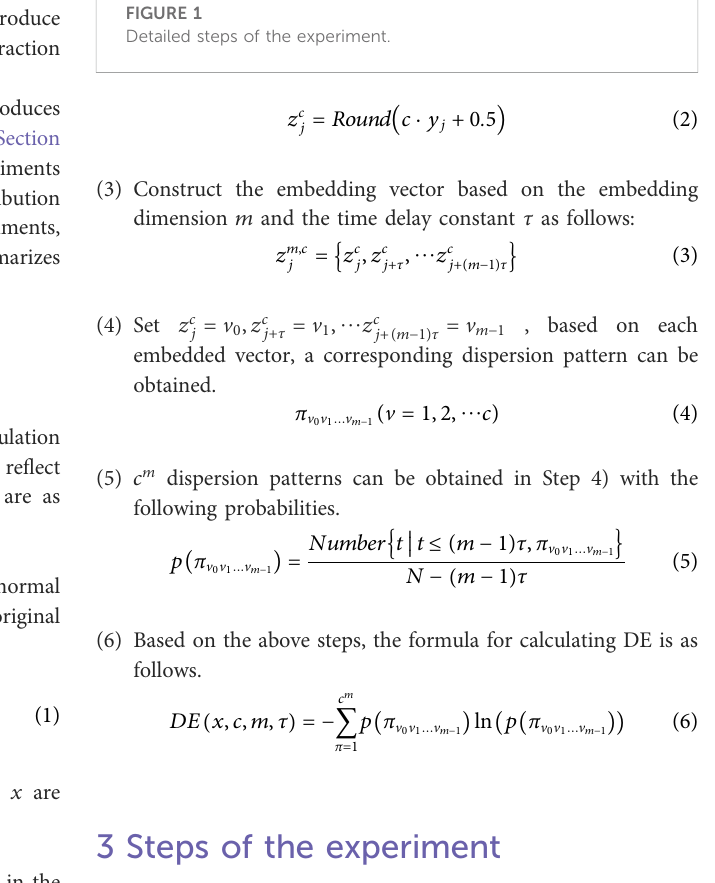
FIGURE 1 Detailed steps of the